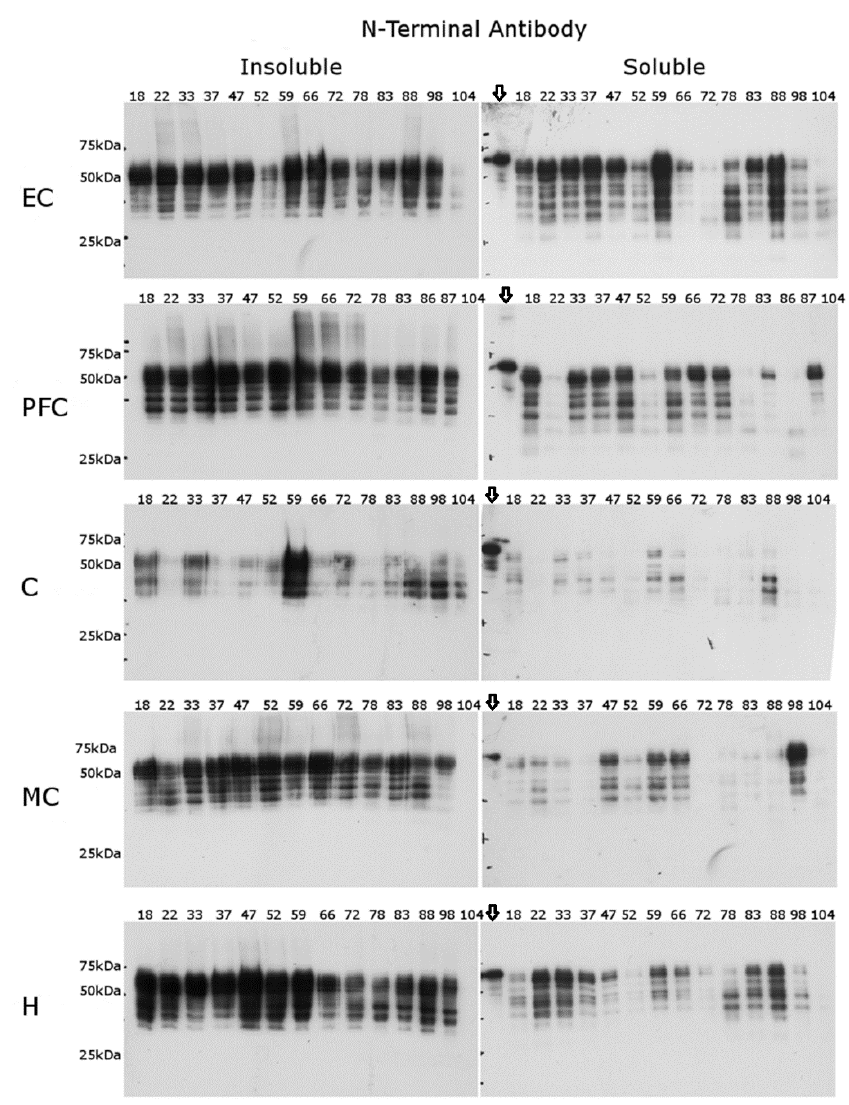
Figure 4. Soluble and insoluble fractions from the same brain regions using an N-terminal antibody. Western blot analysis of the N-terminus of Tau. Both insoluble and soluble fractions were probed with an antibody specific to the N-terminus of Tau in five brain regions: the entorhinal cortex (EC), prefrontal cortex (PFC), cerebellum (C), motor cortex (MC), and hippocampus (H). The ages are displayed above each lane. Downward arrow Tau 441 standard.